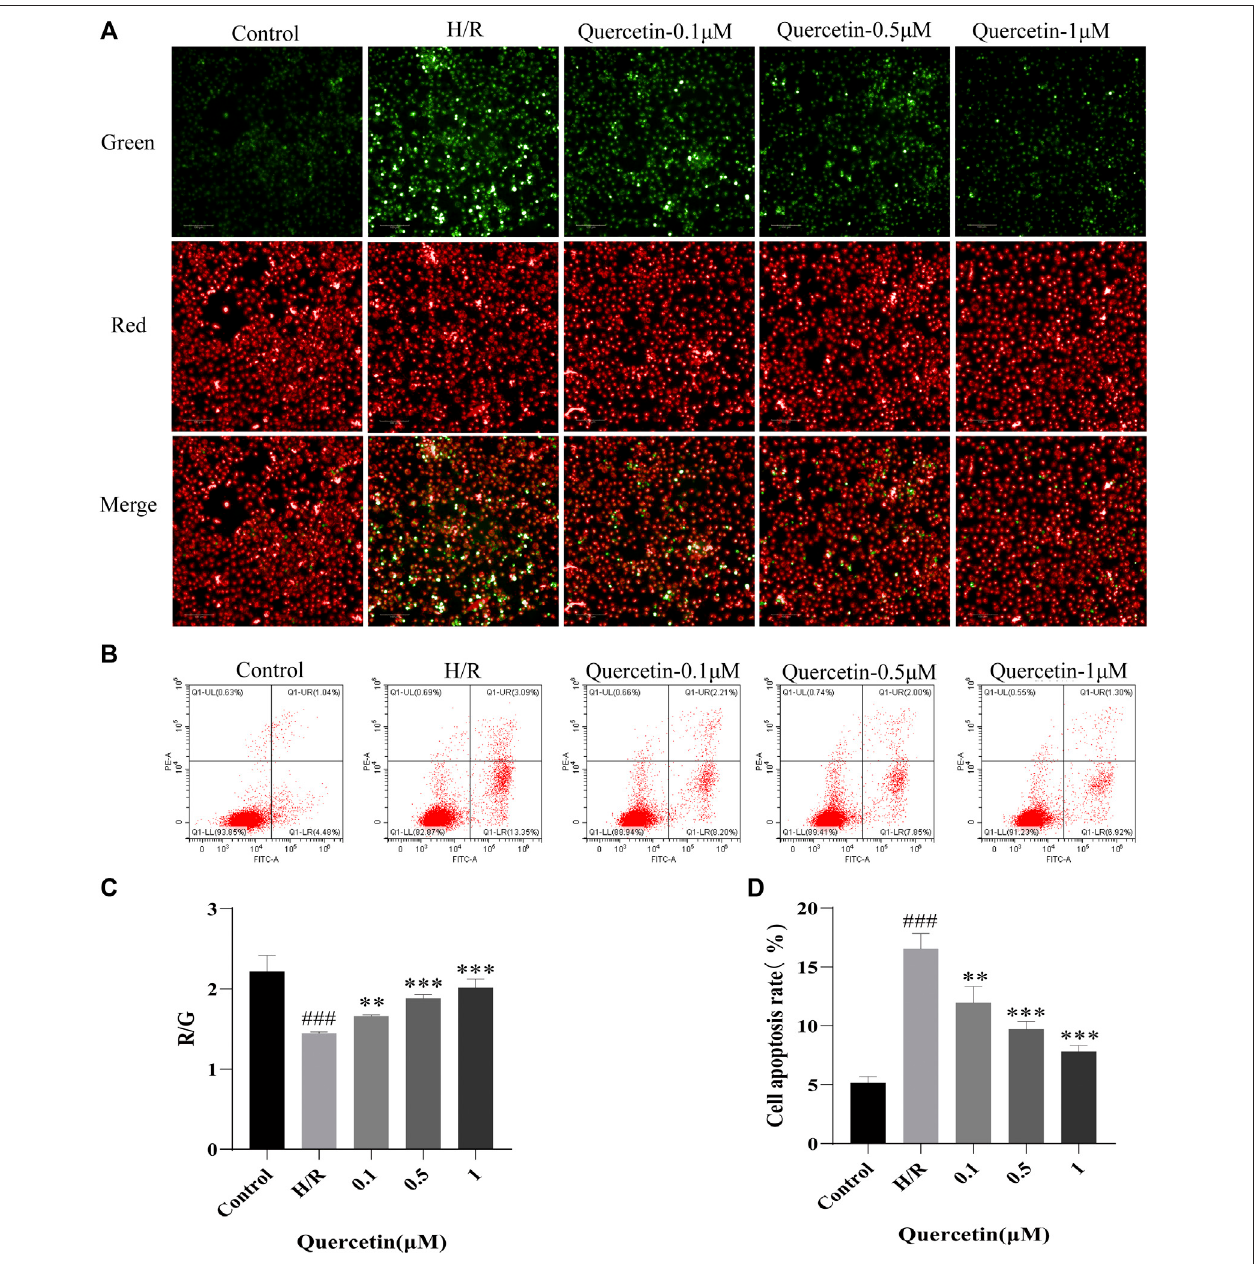
FIGURE 3 | (A) The mitochondrial membrane was examined using JC-1 probe (B) Apoptosis was evaluated using fl ow cytometry (C) R/G represents altered mitochondrial membrane potential (D) Apoptosis data was analyzed. ### p < 0.001 compared to control group; ** p < 0.01, *** p < 0.001 compared to H/R group. μ